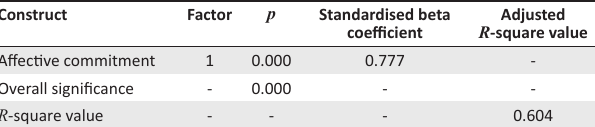
TABLE 8: Influence of affective commitment on calculative